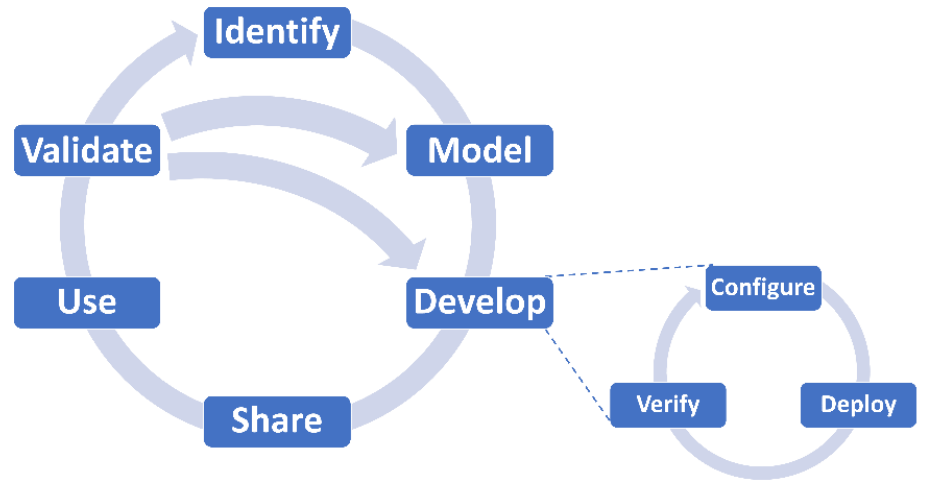
Figure 2. The DT